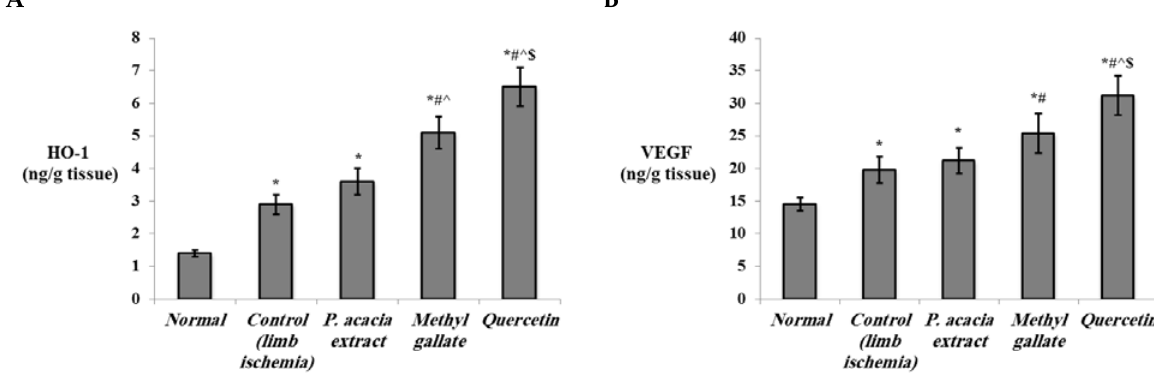
Figure 7. The effect of the P. acacia extract and its isolated compounds (methyl gallate and quercetin) on the levels of ( A ) HO-1 and ( B ) VEGF in the hind limb tissue of the experimental rats ( n = 8). HO-1 = heme oxygenase-1; VEGF = vascular endothelial growth factor. Data are expressed as the mean ± SD and were analyzed using one-way ANOVA followed by Bonferroni’s post hoc test. * Significantly different compared to the normal group, # significantly different compared to the hind limb ischemia control group, ˆ significantly different compared to the group treated with the P. acacia extract, $ significantly different compared to the group treated with methyl gallate. Values were considered significantly different at p < 0.05.